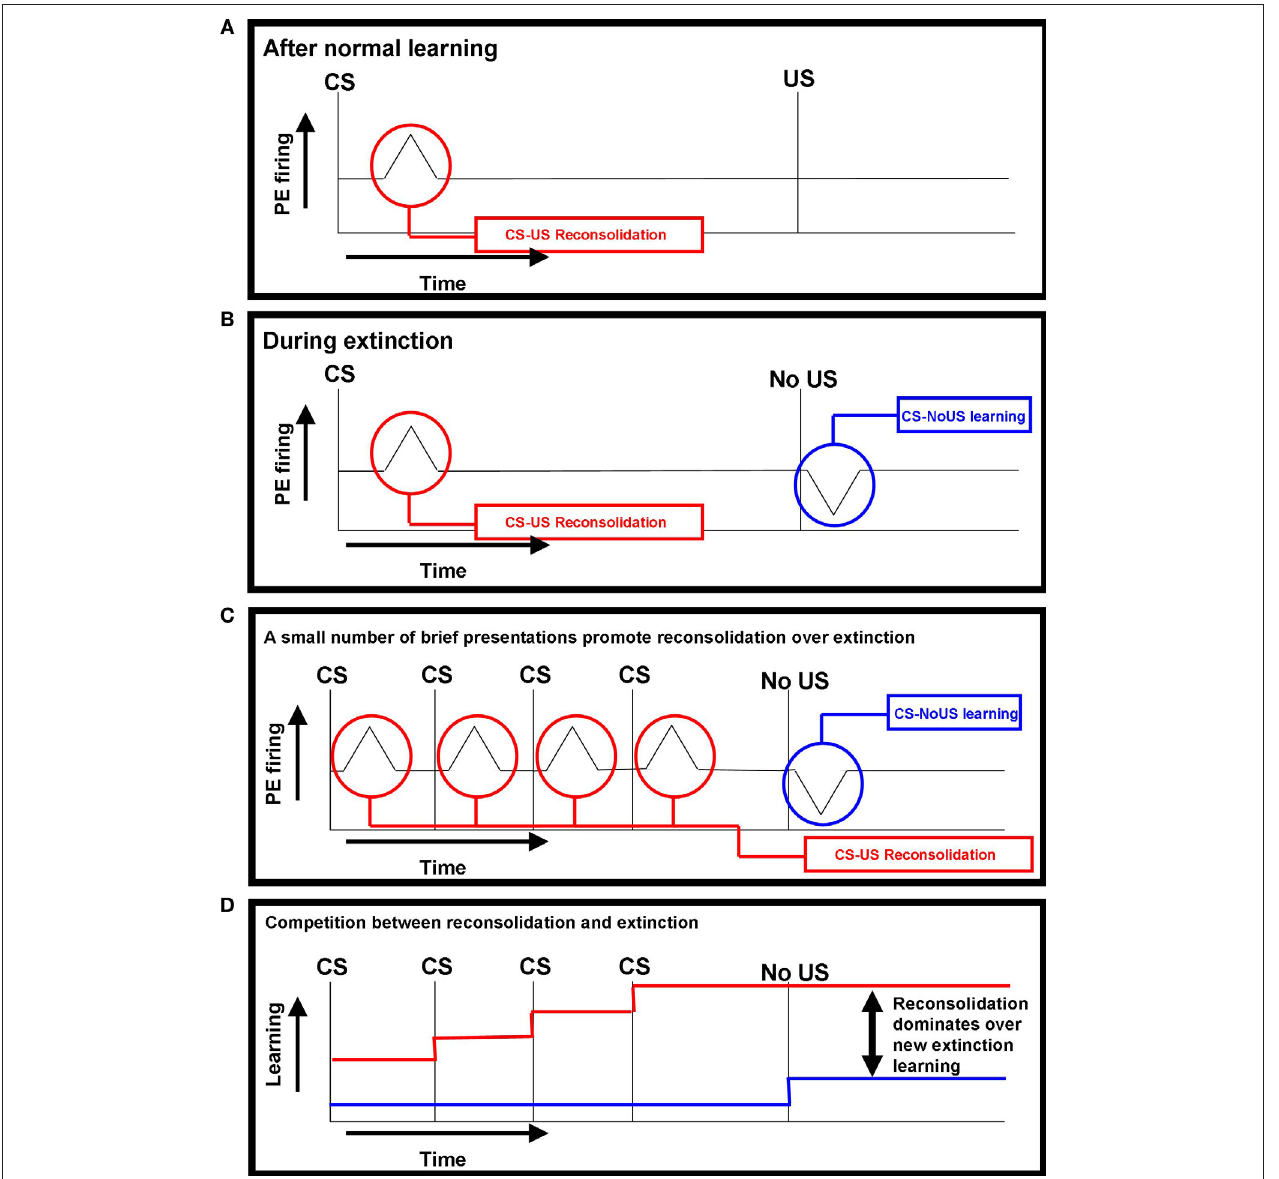
FIGURE 1 | Prediction error responses during learning, extinction and reconsolidation. In these schematics, an upward defl ection from the baseline refl ects a positive prediction error and a downward defl ection represents a negative prediction error (PE). (A) After normal learning – Dopamine neurons come to respond to the conditioned stimulus, the best predictor of the salient outcome (Schultz and Dickinson, 2000). When the CS is presented, the organism is reminded of the salient event (represented in red). (B) During extinction – When the salient event does not occur, a negative prediction error promotes new extinction learning: the formation of a competing CS–NoUs association (represented in blue) (Bouton, 2000; Eisenhardt and Menzel,